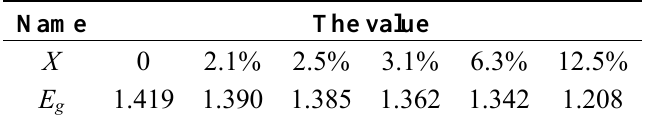
Bi ( a ) x = 0; ( b ) x = 2.1%; ( c ) x = 2.5%; 1 − x x